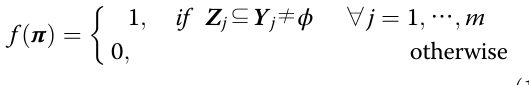
Table 1 Evaluation of the probability of the corresponding individual SN states for a given WSN state= X s , X t , X p , X b } , where “ true ” and “ false ” are denoted by 1 and 0, respectively, and λ i